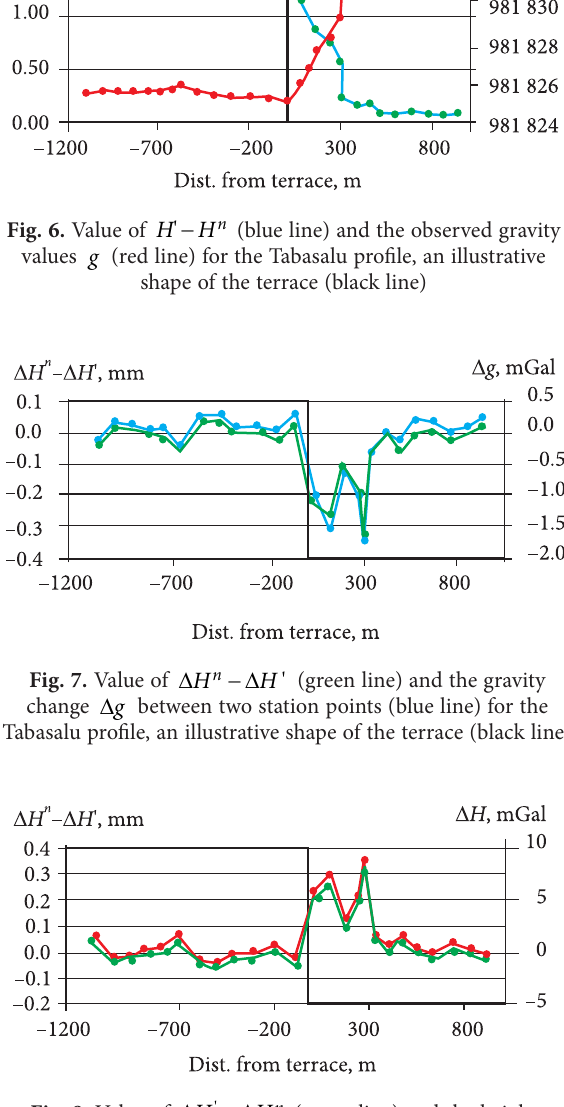
Fig. 8. Value of ' n H H ∆ − ∆ (green line) and the height change H ∆ between two station points (brown line) for the Tabasalu profile, an illustrative shape of the terrace (black